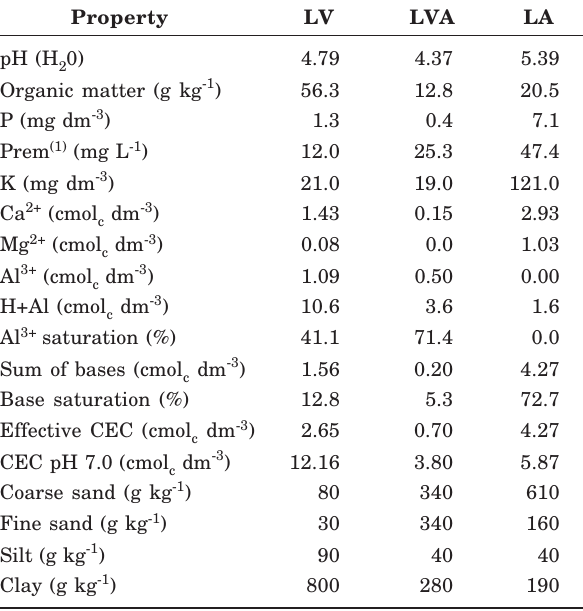
Table 1. Chemical and physical properties of the soil samples used in the